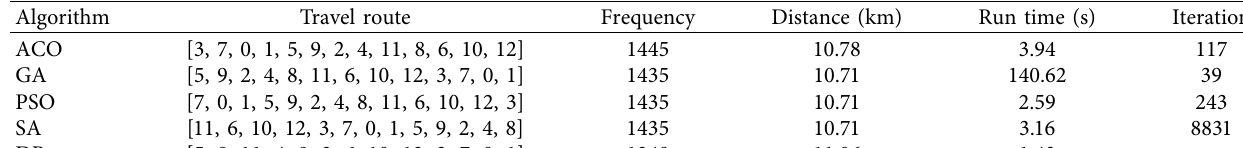
Table 2: Performance analysis of each optimization algorithm. Algorithm